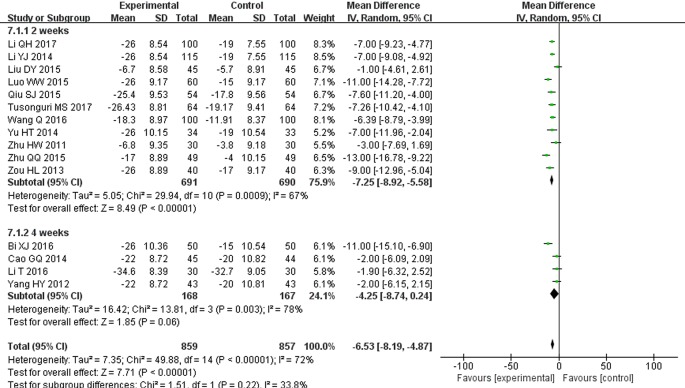
Meta-analysis for comparison of systolic blood pressure (SBP) between the experimental and control groups.